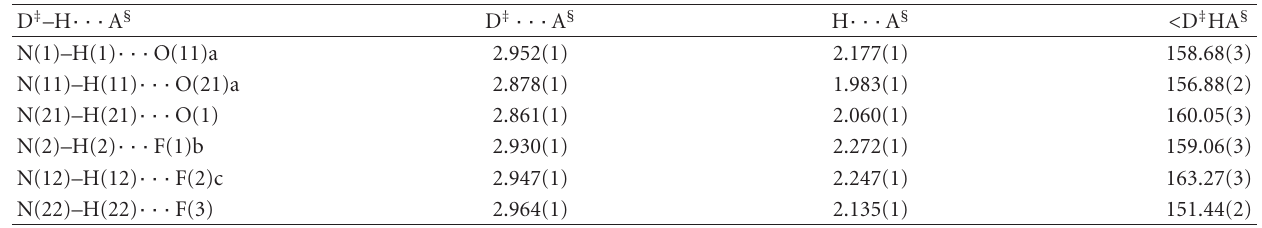
Table 6: Dimensions of the unique hydrogen bonds (distances in ˚A and angles in ◦ ) for complex 1 .